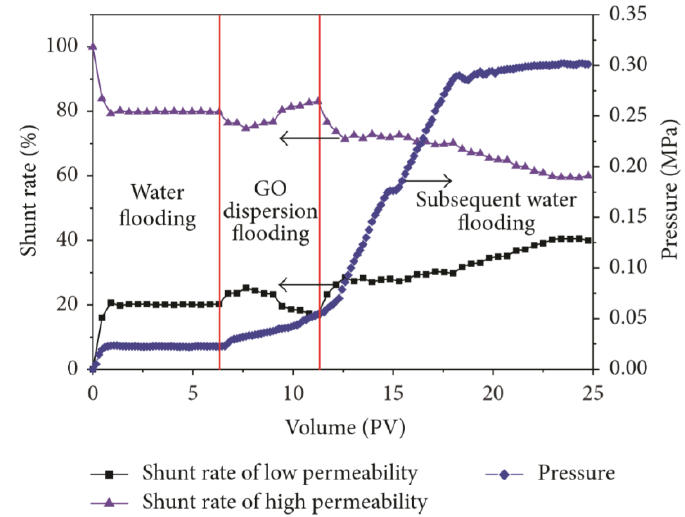
Figure 9. Pressure curves of the flooding experiment in the two parallel cores [152].